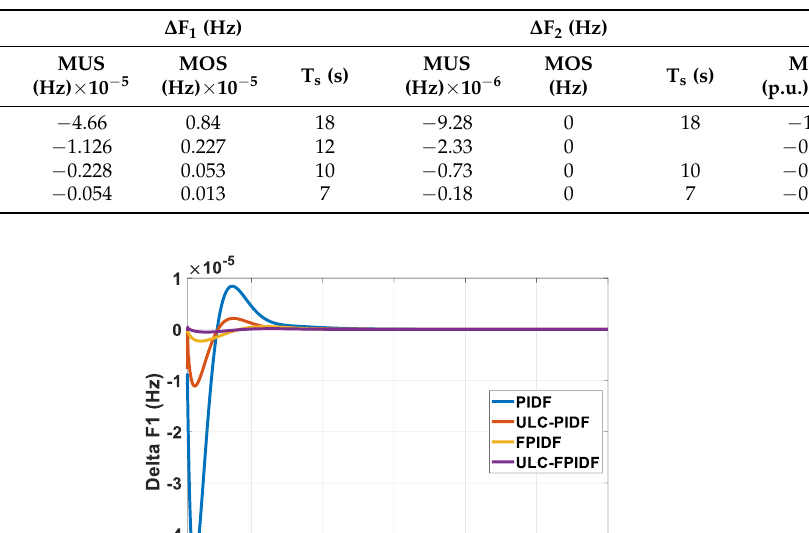
Table 4. Transient expectations for 5% SLP utilizing various controllers.